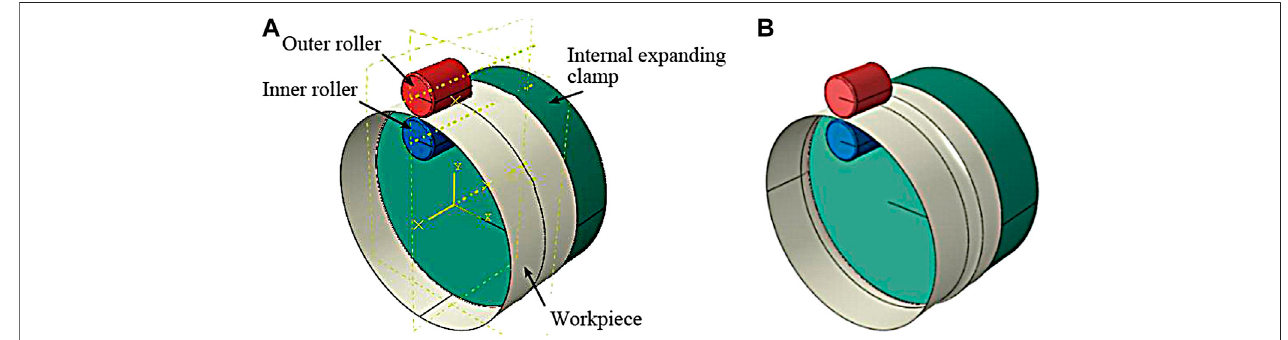
FIGURE 8 | (A) Wall thickness distribution on the contraction segment of a wind concentrator. (B) Wall thickness distribution on the expanding segment of a wind concentrator.